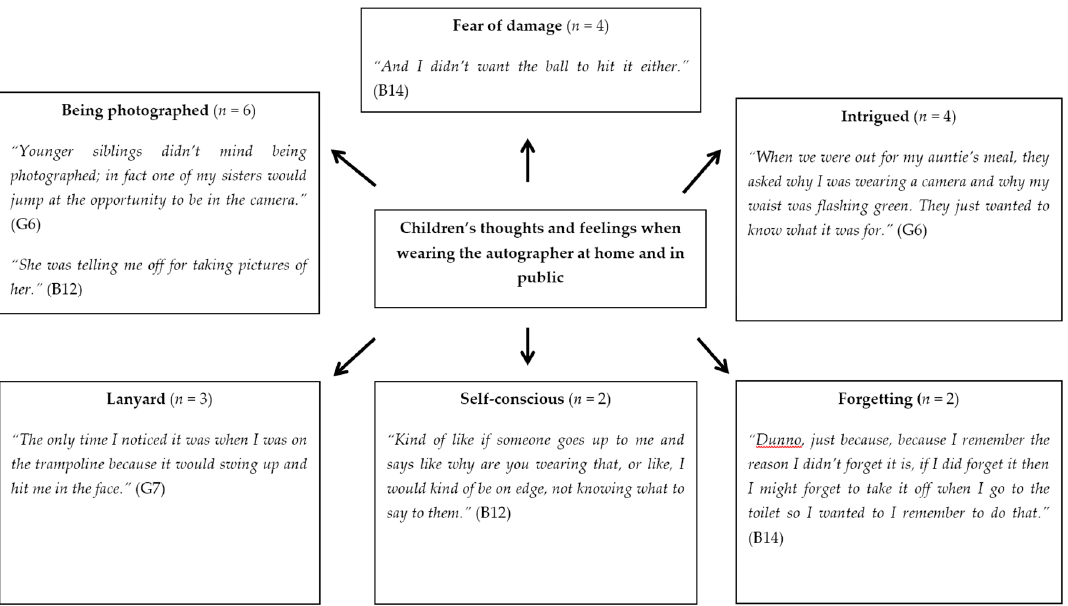
Figure 8. Pen profile depicting children’s thoughts and feelings when wearing the autographer at home and in public (B = Boy, G = Girl). n shows the number of individual responses.